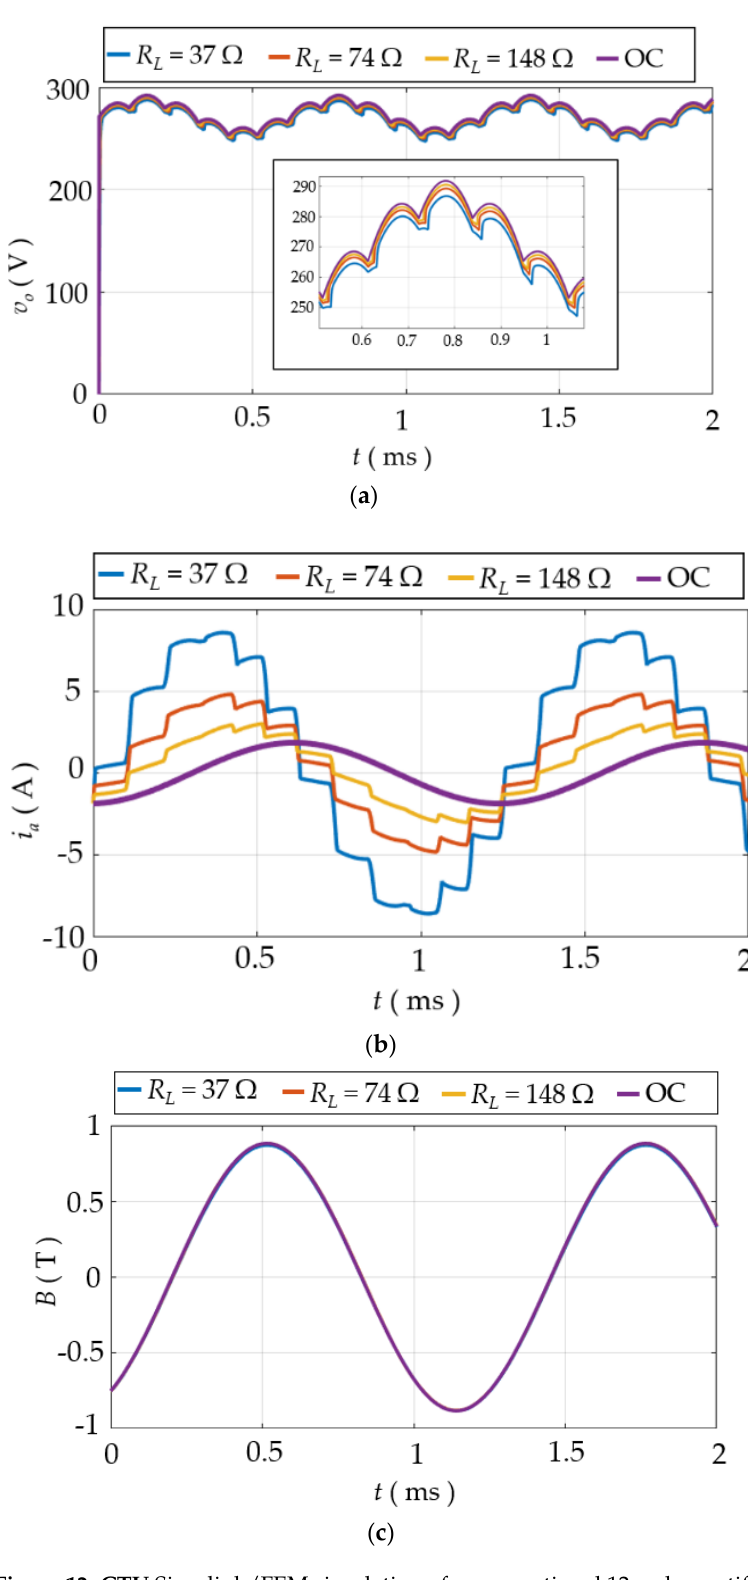
Figure 12. CTU Simulink/FEM simulation of a conventional 12-pulse rectifier. ( a ) Output voltage. ( b ) Input current. ( c ) Magnetic flux density.